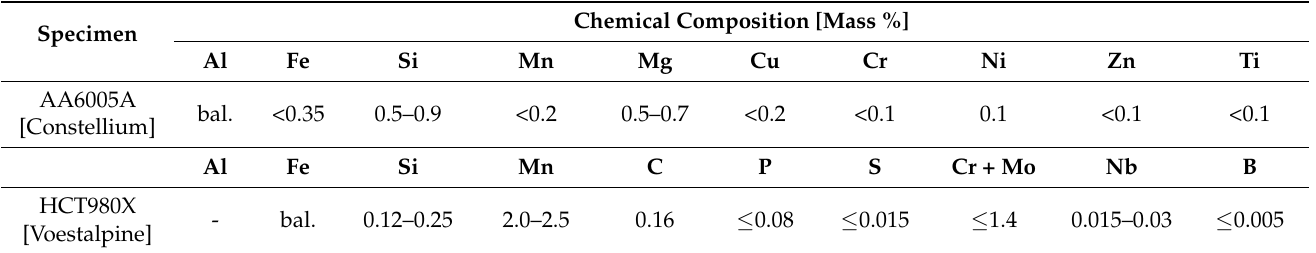
Table 1. Chemical composition of the chosen aluminum and steel sheets in mass % (provided by Constellium and Voestalpine). Specimen